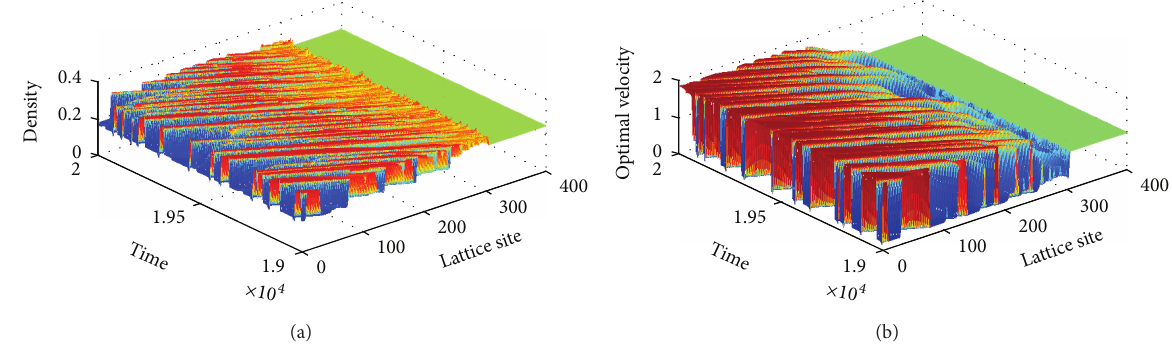
Figure 7: The spatiotemporal evolutions of OCT for 𝜌 ℎ = 0.25 , 𝑄 on = 0.12 .